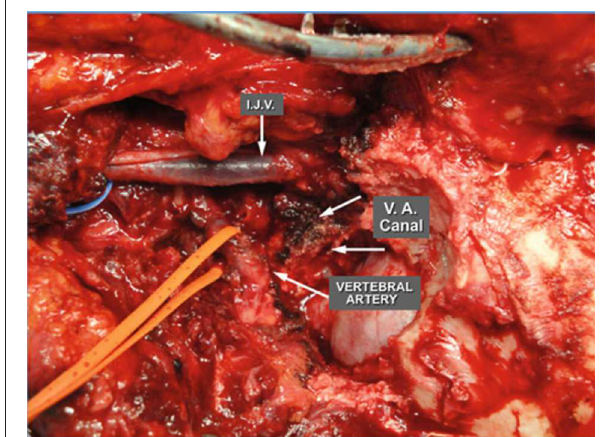
FIGURE 13 | Skull base after neck dissection and transposition of the vertebral artery ( 3). IJV, internal jugular vein; VA, vertebral artery. [Modified from Ramina and Tatagiba (3)].